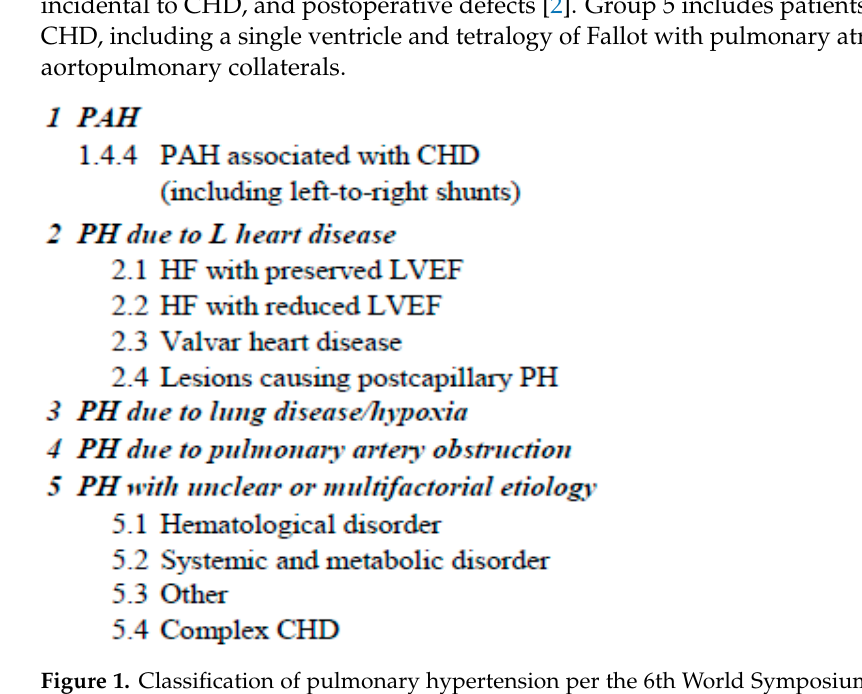
Figure 1. Classification of pulmonary hypertension per the 6th World Symposium on Pulmonary Hypertension (Adapted figure).